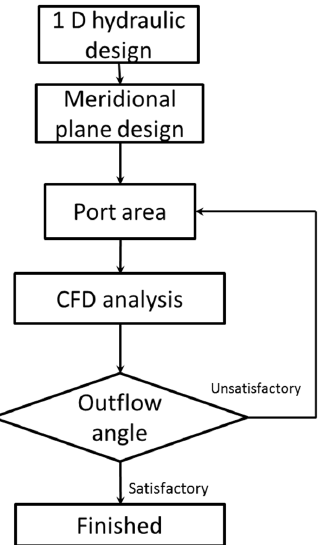
Figure 1. Flow chart of Francis turbine runner blade design. CFD: computational fluid dynamics.